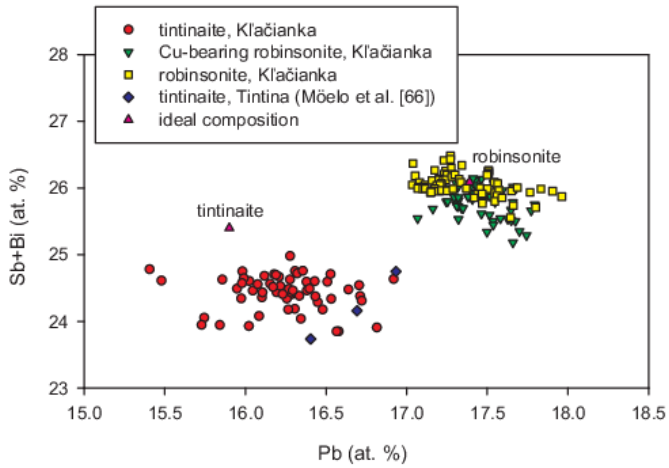
Figure 6. Chemical composition of robinsonite and tintinaite in the graph Pb vs. Sb + Bi (at.%); theoretical composition: robinsonite Pb 4 Sb 6 S 13 ; tintinaite Pb 10 Cu 2 (Sb,Bi) 16 S 35 .